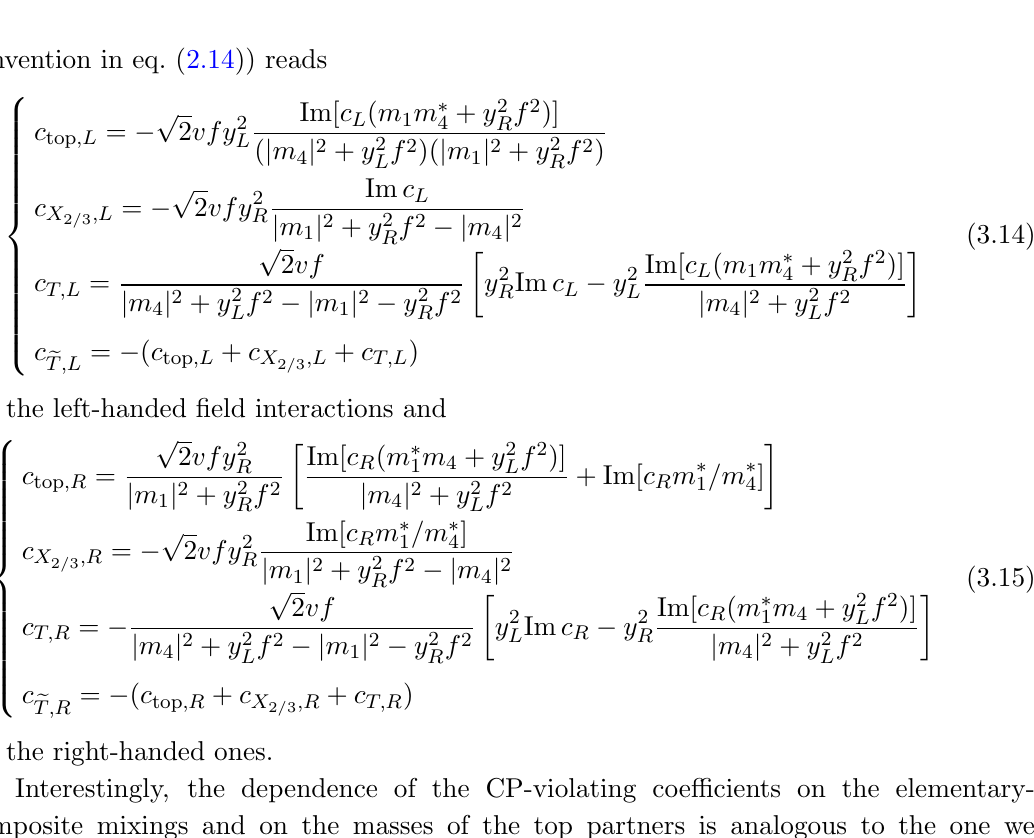
Figure 10 . Estimate of the bound on the compositeness scale f in the 5 + 5 model. The gray band shows the estimate of the corrections to the electron EDM given in eq. (3.16) for Im (cid:22) c solid red line shows the bound from the present electron EDM measurements, while the dot-dashed and dotted ones show the expected future limits. The blue bands show the constraints from the present and near-future neutron EDM